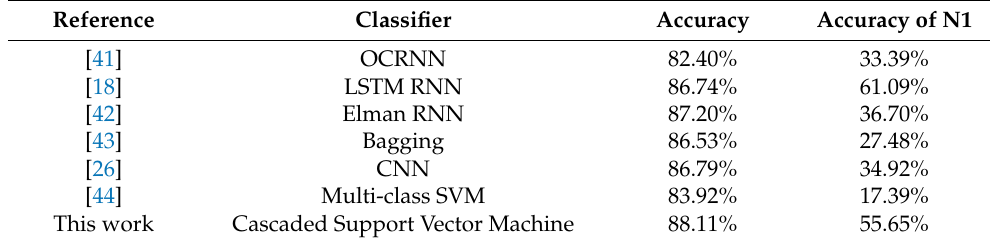
Table 4. The accuracy of the classification for five sleep stages using single-channel methods.